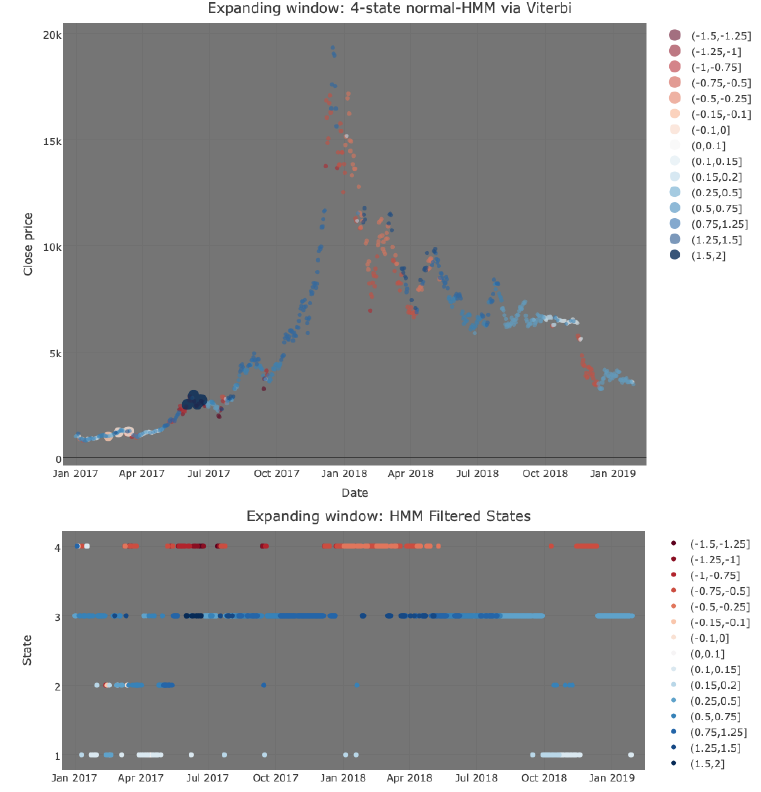
Figure 5. Expanding window: four-state normal HMM filtering via the Viterbi algorithm on BTC/USD. Upper figure: Colours vary by the value of the state-dependent mean (see legend), and the larger the state-dependent volatility, the larger the dot size. Lower figure: The plot indicates the inferred state at each time-point, and the colour code also indicates the value of the state-dependent mean as per the legend. Figure reproduced from